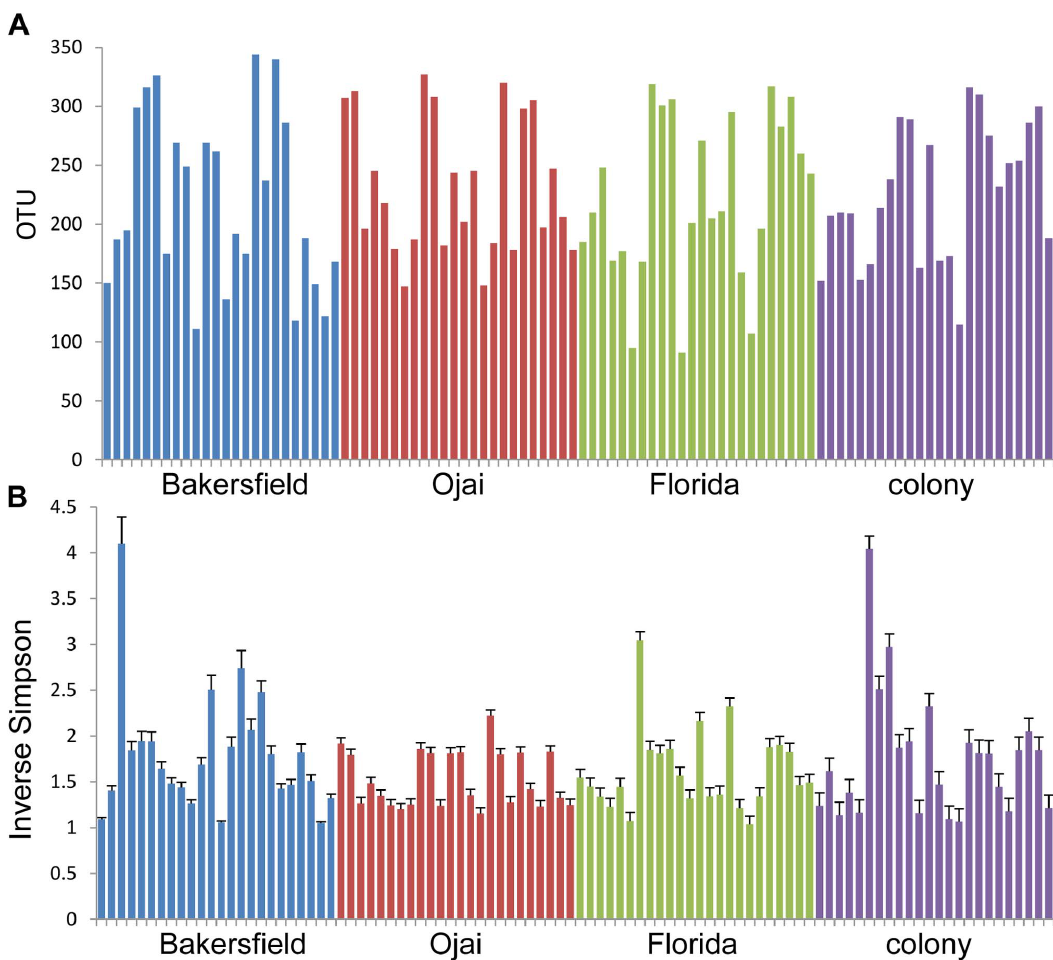
Figure 2. a Diversity Measures. Total number of OTU observed per insect (A) and inverse Simpson index (B) for each of the 96 insects as calculated using mothur. Error bars in B are 95% confidence levels. Bars are color-coded: blue (Bakersfield), red (Ojai), green (Florida), and purple (colony).